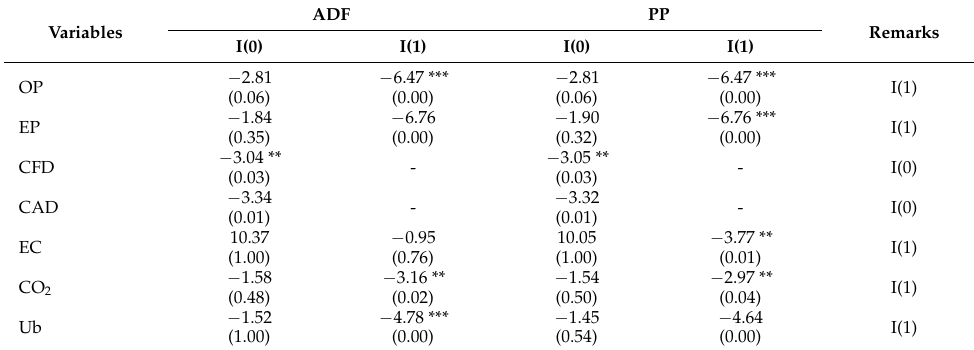
Table 3. Results of unit root